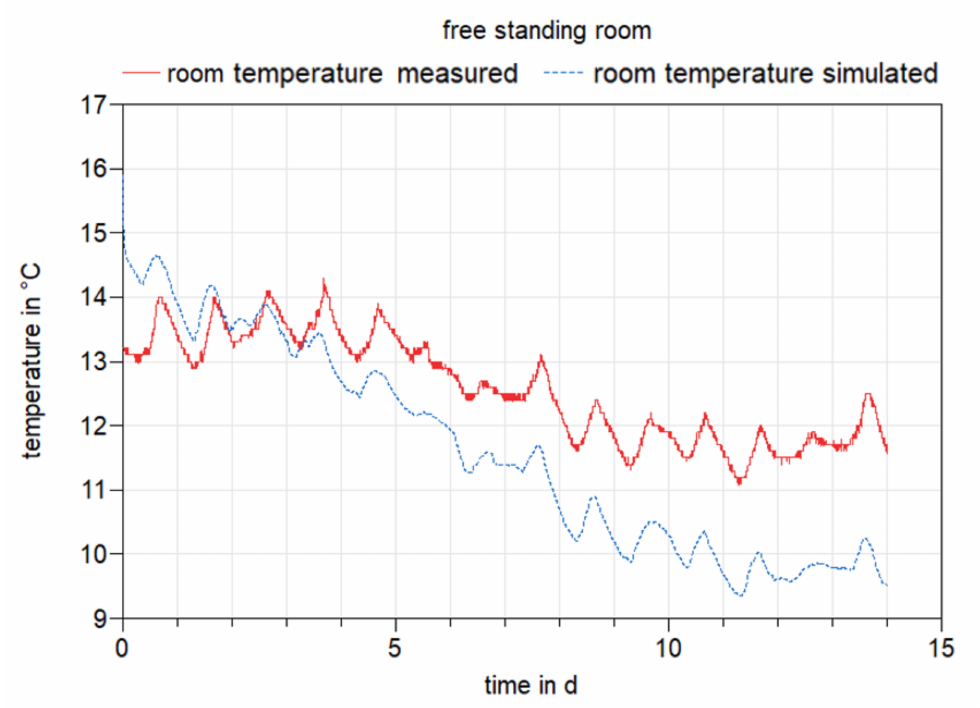
Figure 7. Validation against measurements (Supplementary